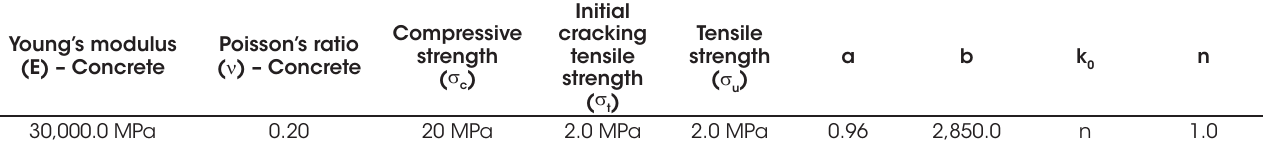
Reinforced concrete beam: material parameters for a concrete Young’s modulus Poisson’s ratio (E) – Concrete ( ν ) – Concrete